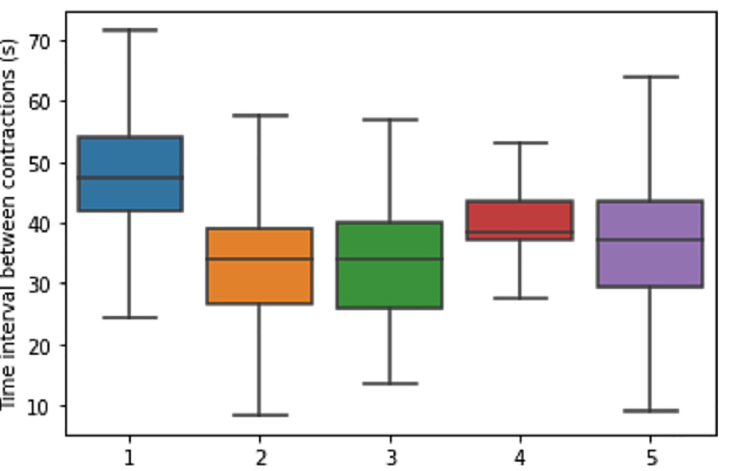
Fig 4. Boxplot of the time between two contraction cycles during the different behaviors. Time between two contraction cycles in seconds, during different behaviors: (1) Rumination; (2) Eating; (3) Drinking; (4) Sleeping; (5) Other. Boxplots depict the median and the upper and lower quartiles; whiskers depict quartiles ± 1.5 × the interquartile range (IQR); outliers not shown.